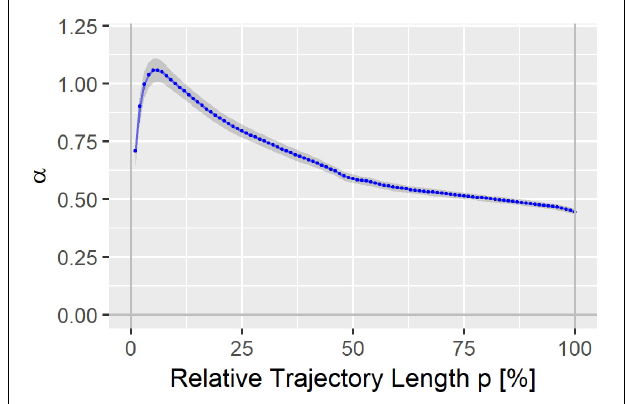
FIGURE 2 | Heart rate correction exponent α for the T vector trajectory quantiles Tr(p). The gray band denotes α ± standard